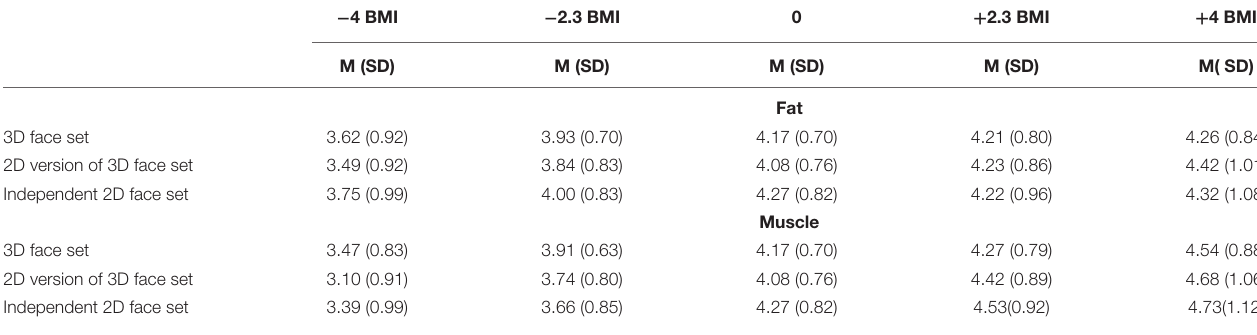
TABLE 1 | Descriptive statistics of mean masculinity ratings (1 − 7) (SD) for three sets of faces transformed in fat mass and muscle mass dimensions at five BMI